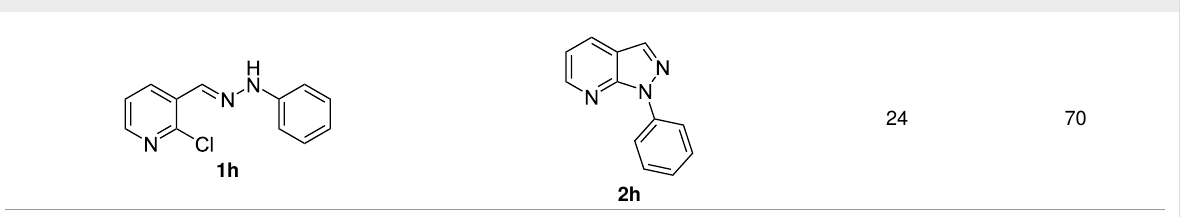
Table 2: Selected experimental data for the synthesis of N -phenyl-1 H -indazoles 2a , b , d – h . (continued)